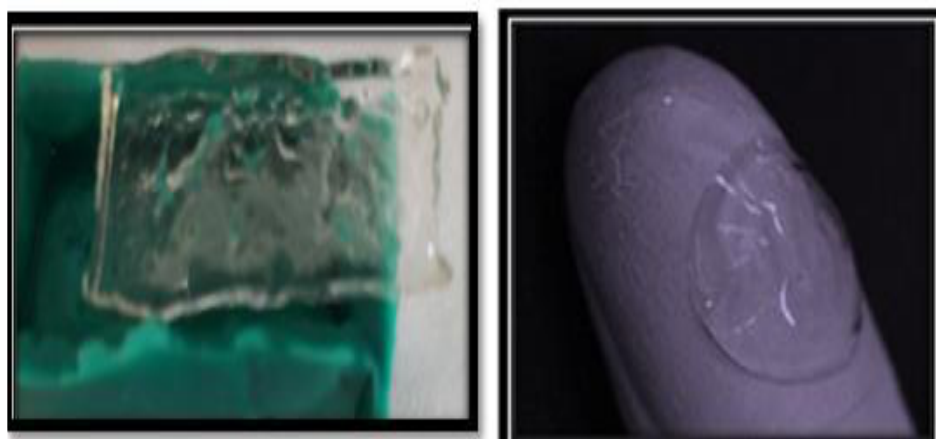
Fig. 7. prepration of